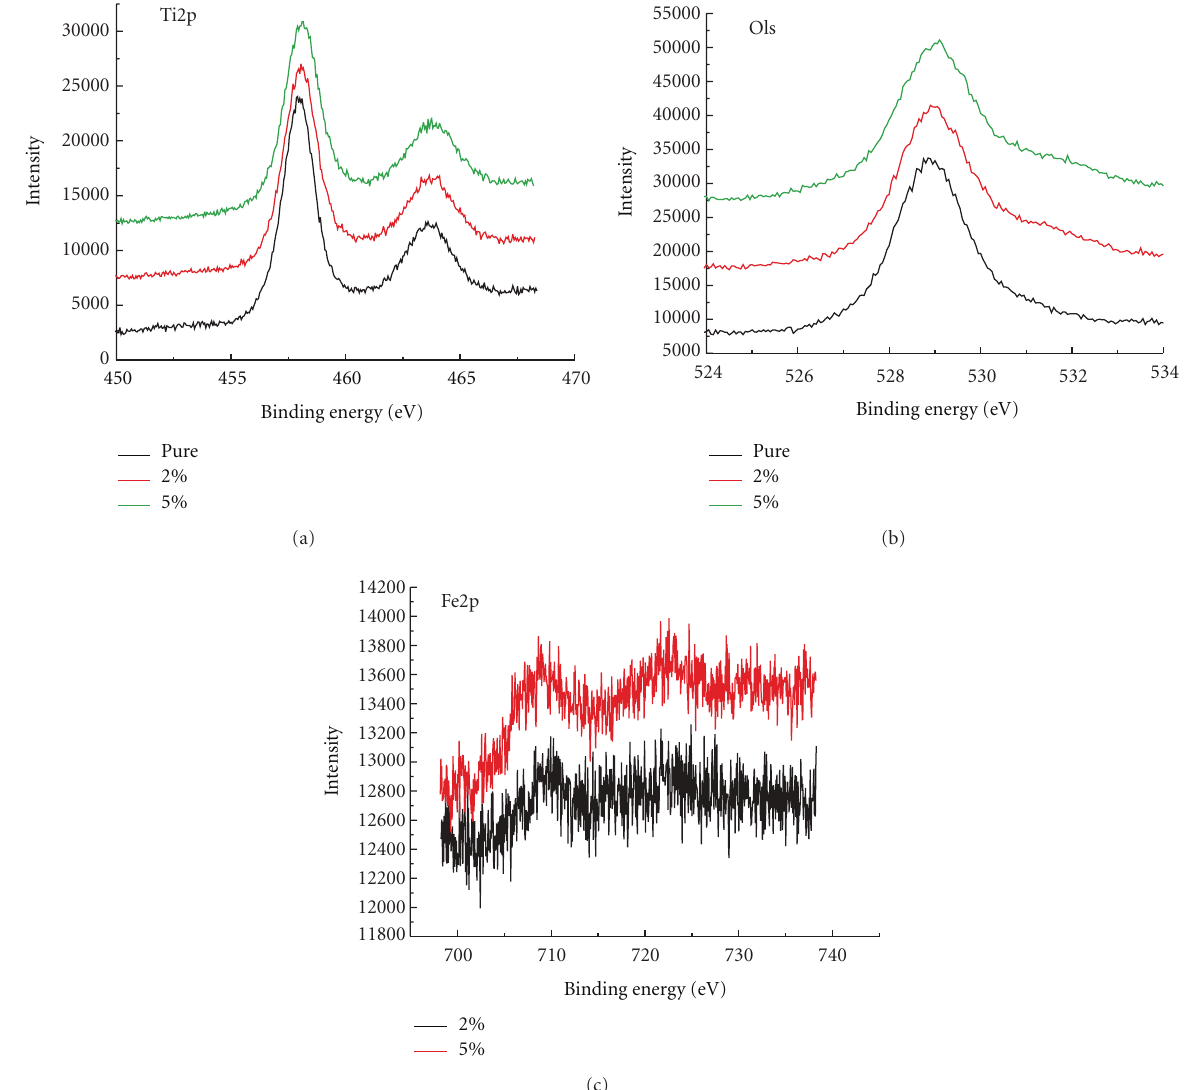
Figure 3: The O1s, Ti2p, and Fe2p core XPS spectra of 0.0, 2.0, and 5.0% Fe-doped TiO 2 samples.